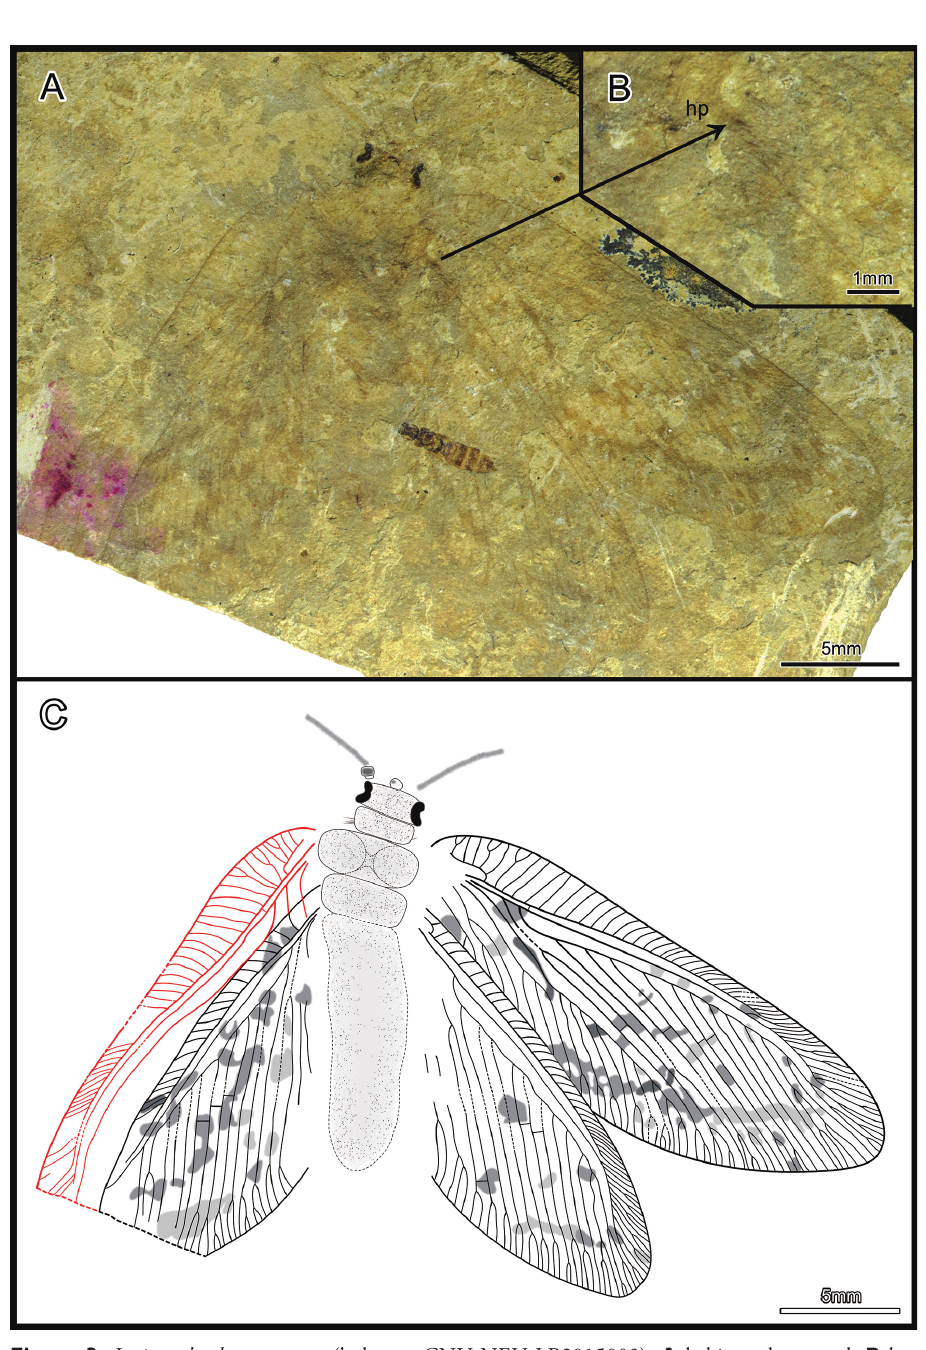
Figure 3. Lasiosmylus longus sp. n. (holotype CNU-NEU-LB2015003). A habitus photograph B hp, humeral plate (left hindwing) C line drawing. Scale bars: 5 mm ( A, C ), 1 mm ( B